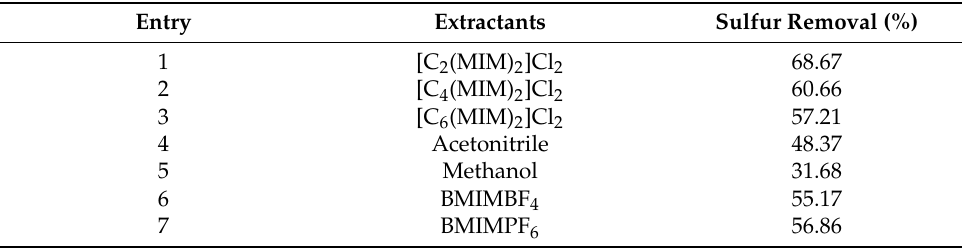
Table 5. Effect of different extractants on the removal of DBT.